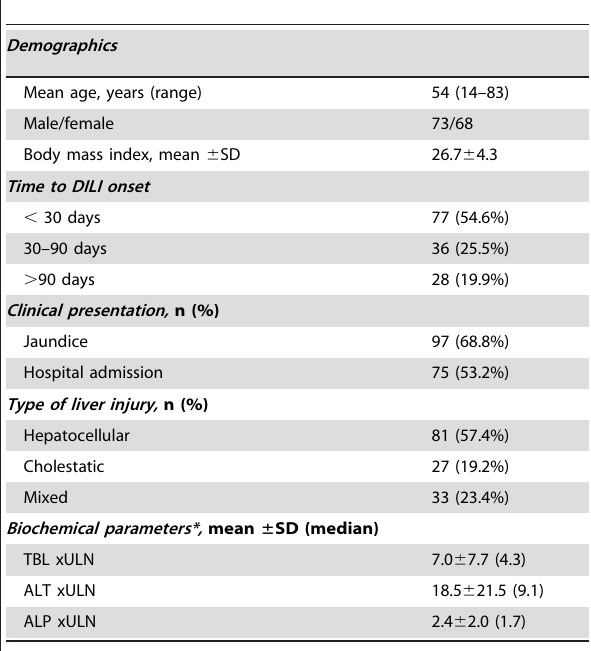
Table 1. Demographics, clinical and laboratory parameters of the 141 DILI cases included in the study.